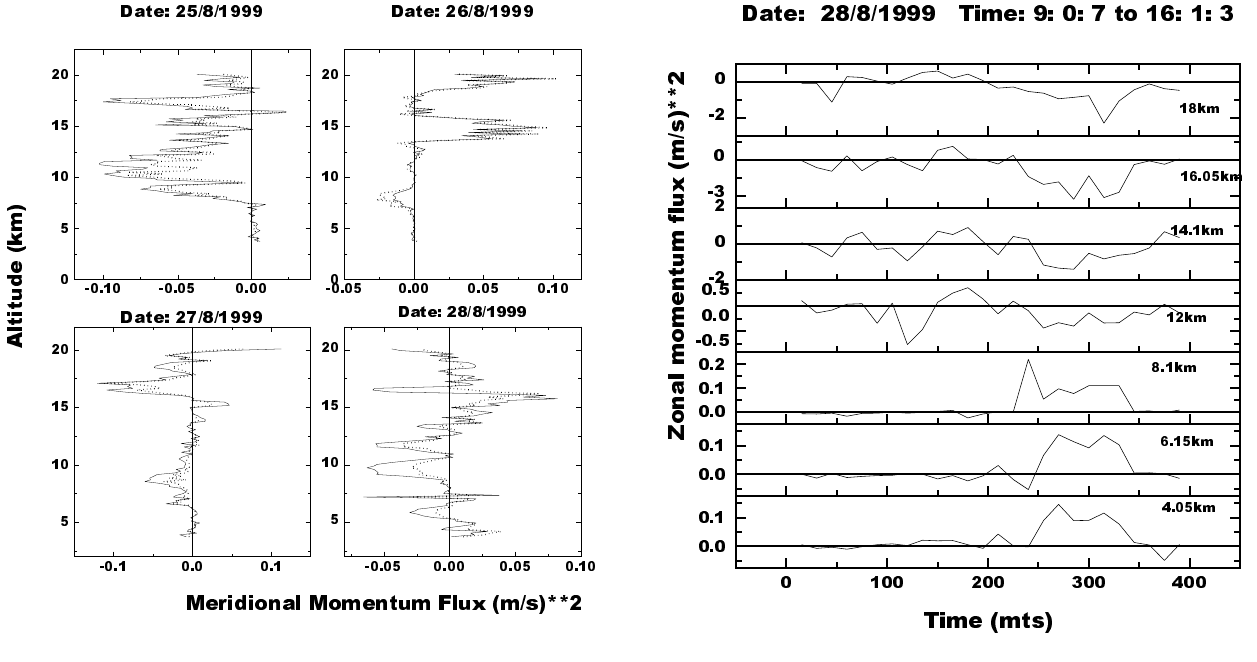
Fig. 11. Mean meridional momentum flux profiles for 25, 26, 27 and 28 August 1999 using the SB method (full lines) and the PS method (dashed lines).